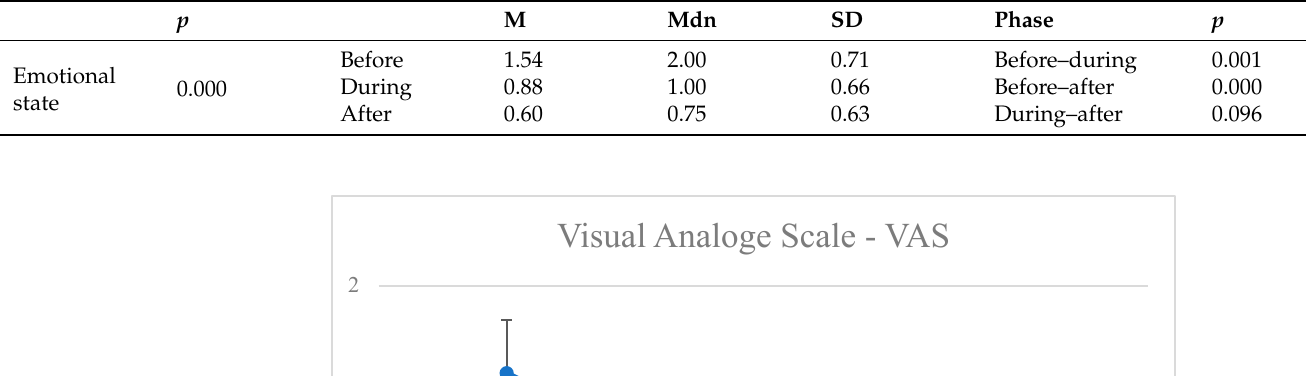
Figure 4. Observed ratings of emotions before, during, and after VR exposure using the OERS .